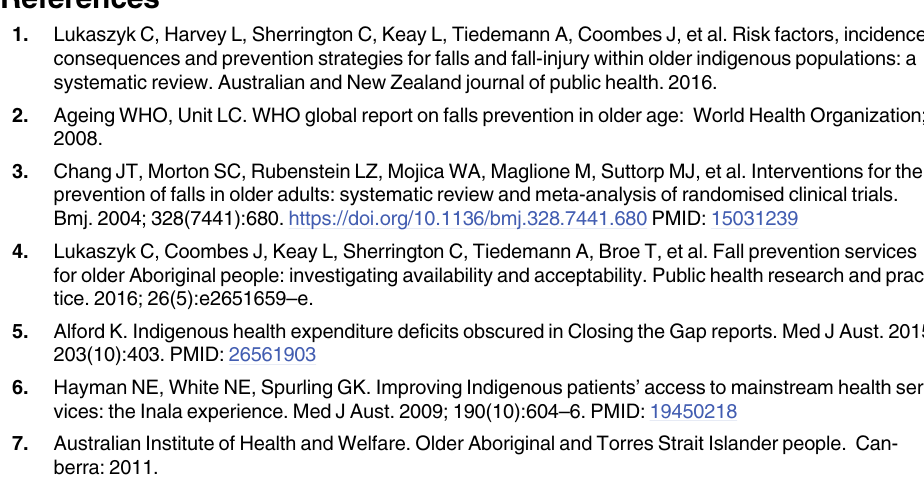
S1 Table. S1 –Multinomial logistic modelling